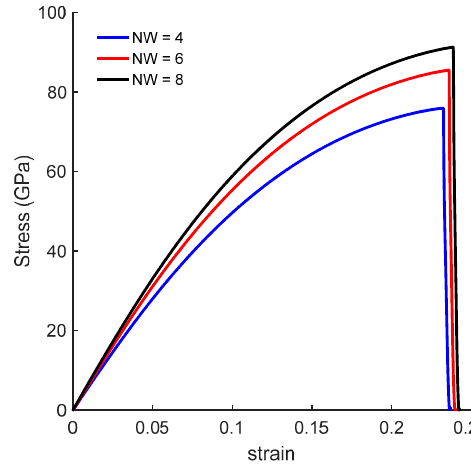
Figure 7. Stress–strain curves of CGNR with mixed edges.